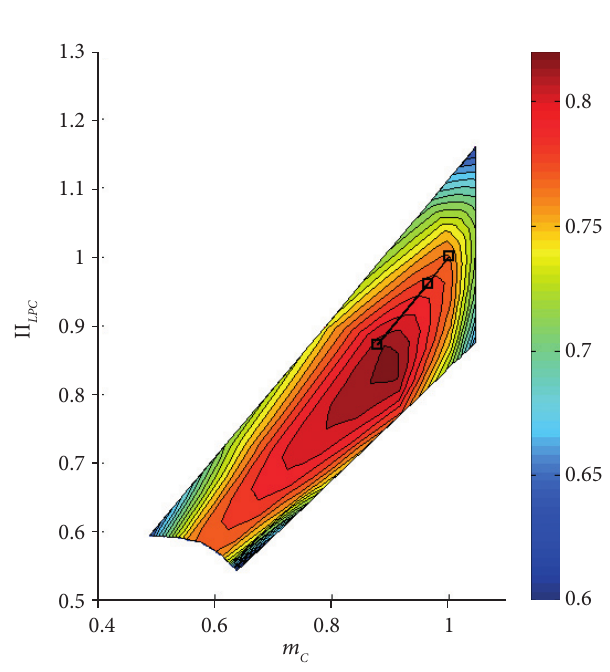
Figure 6. Multipoint scaled LPC map.